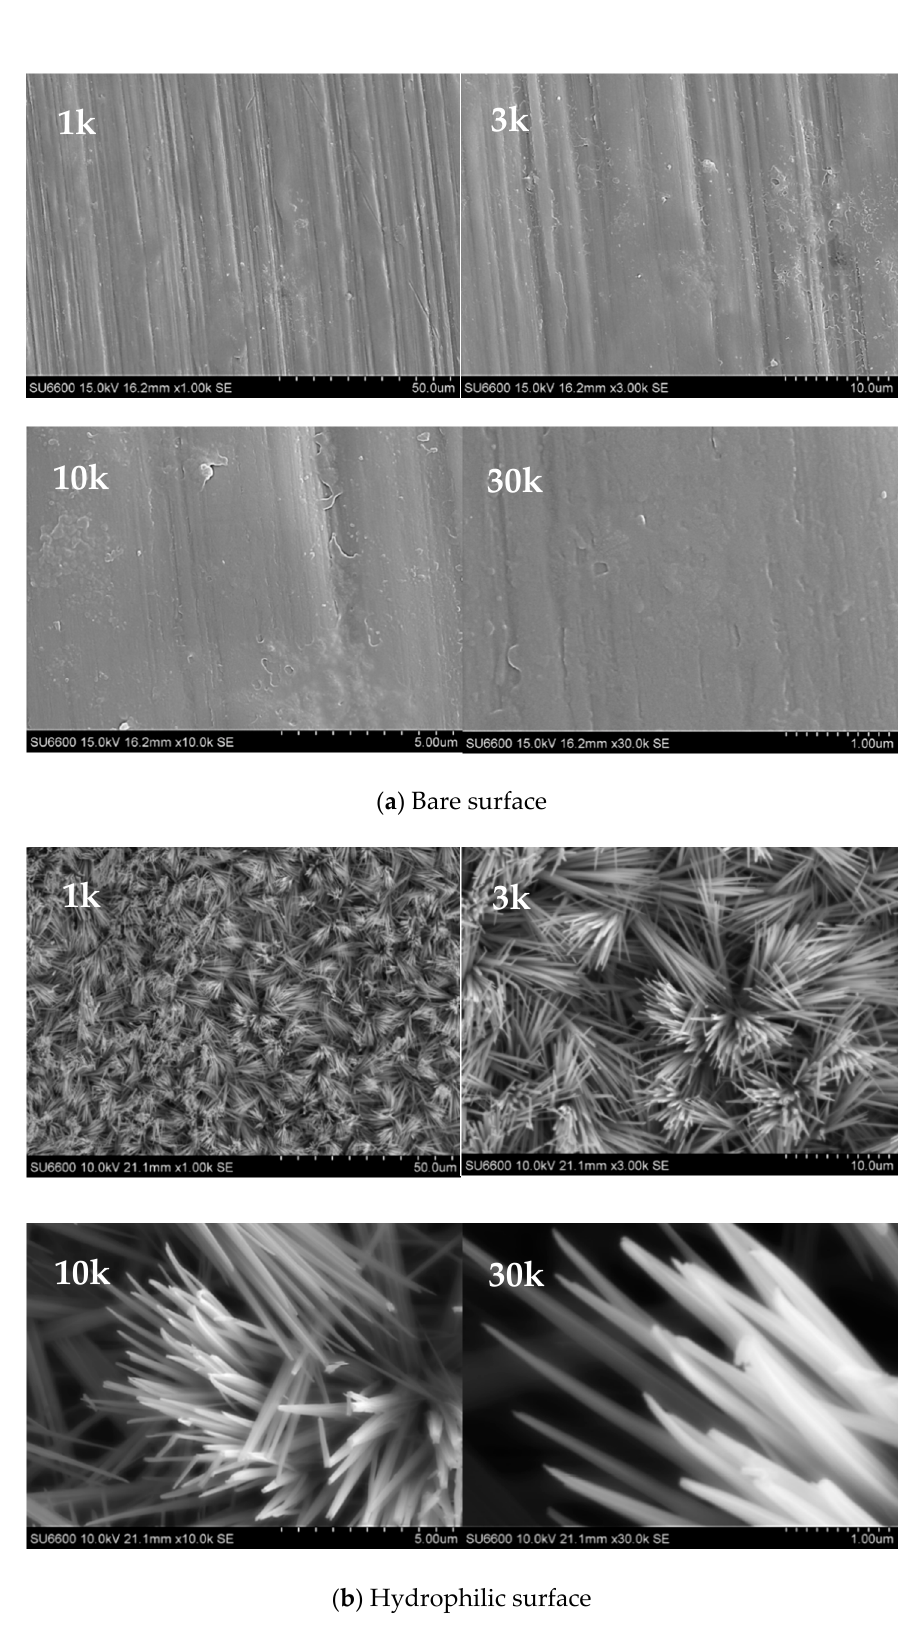
Figure 4. SEM image of the copper surface.